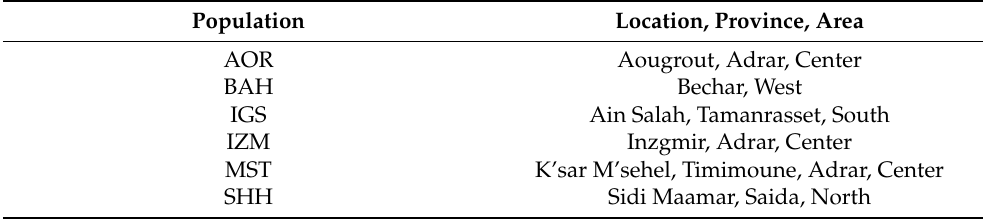
Table 2. Classification of the six maize populations from Algeria used in this diallel matting design based on geographic origin